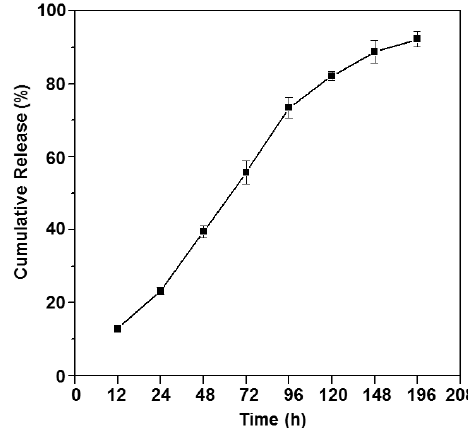
Figure 9. In vitro Dox release profile of P2 gel at 37 °C in PBS. Average release percentage and standard deviation were plotted ( n = 3).